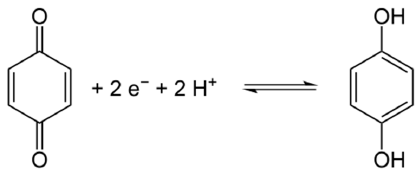
Figure 4. Schematic reduction of 1,4-benzoquinone.